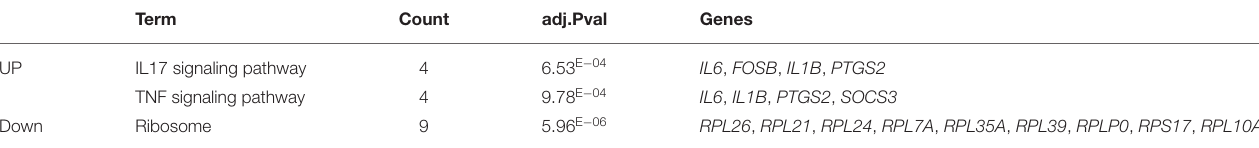
TABLE 2 | The Kyoto Encyclopedia of Genes and Genomes (KEGG) pathway analysis of differentially expressed genes (DEGs).